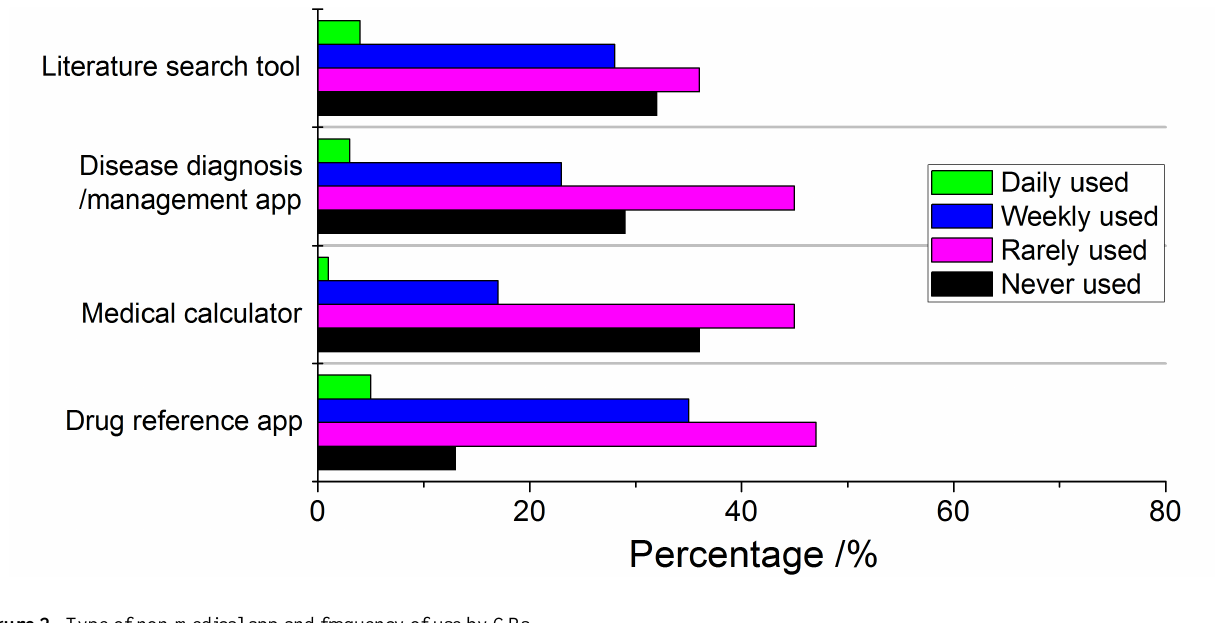
Figure 2. Type of non-medical app and frequency of use by